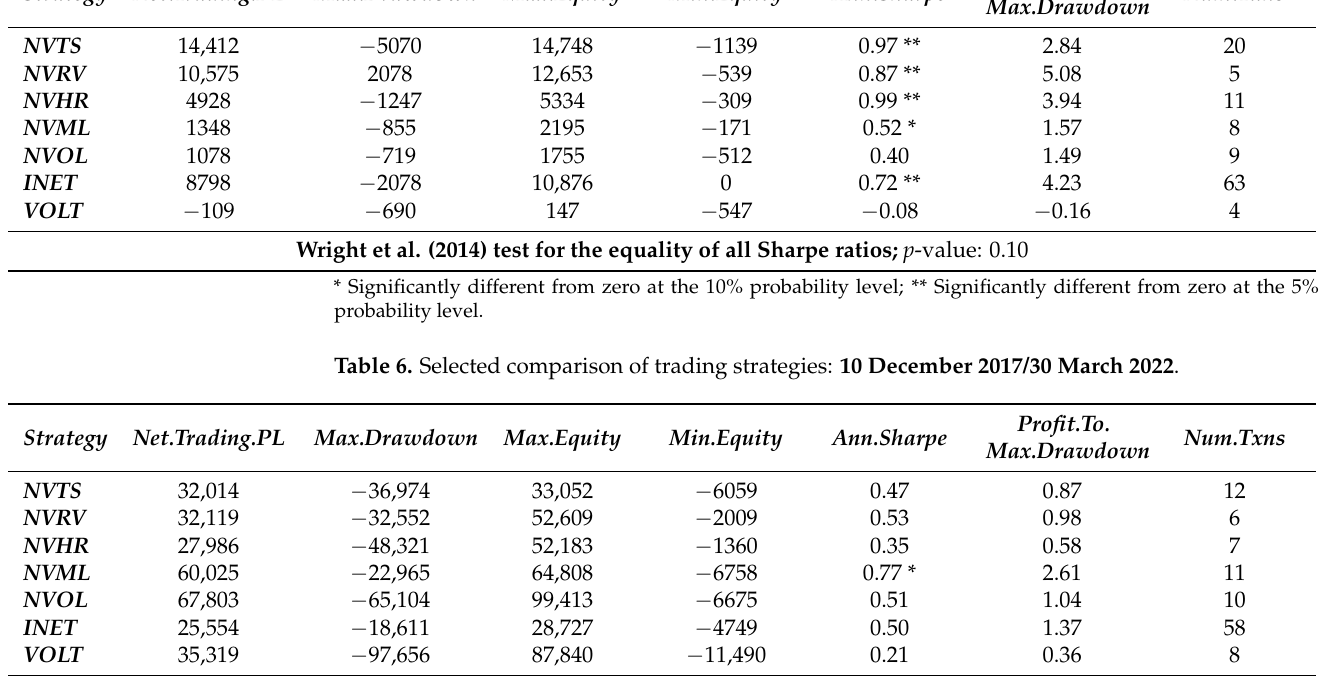
Table 5. Selected comparison of trading strategies: 17 August 2011/9 December 2017 . Strategy Net.Trading.PL